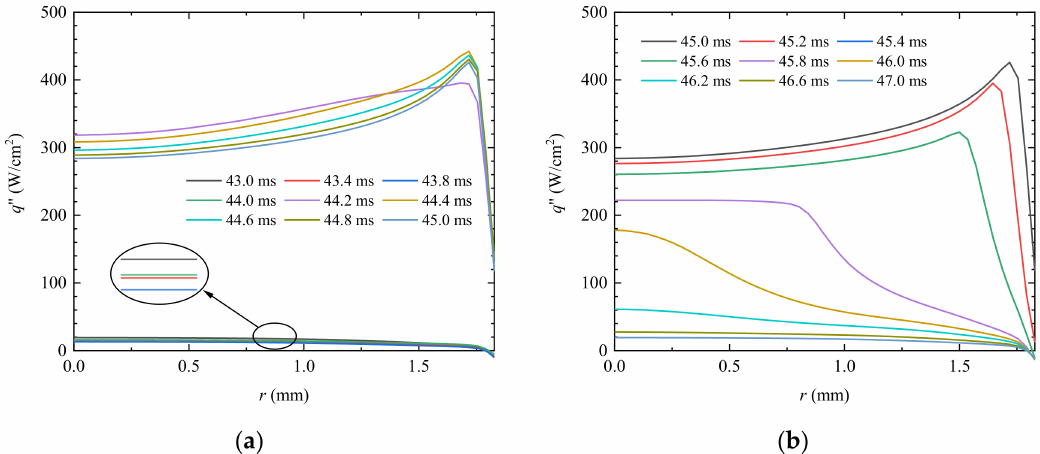
Figure 12. The change processes of heat flux on the upper side of the metallic PCM during a heat pulse cycle: ( a ) 43~45 ms, the duty period with heat flux of 600 W/cm 2 on the chip; ( b ) 45~47 ms, the idle period with zero heat flux on the